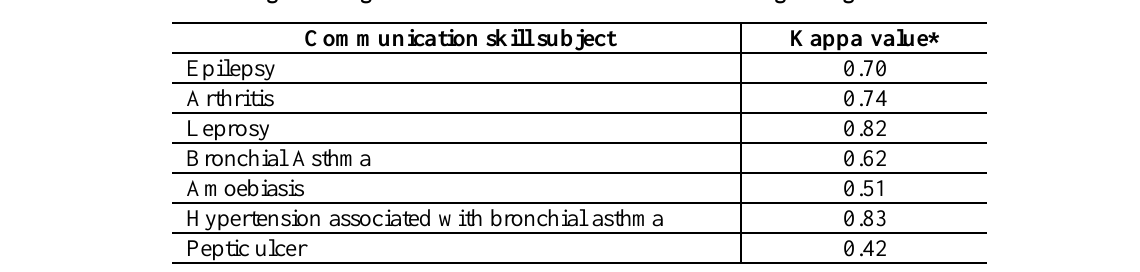
Table I : Degree of agreement between the two observers regarding the total scores